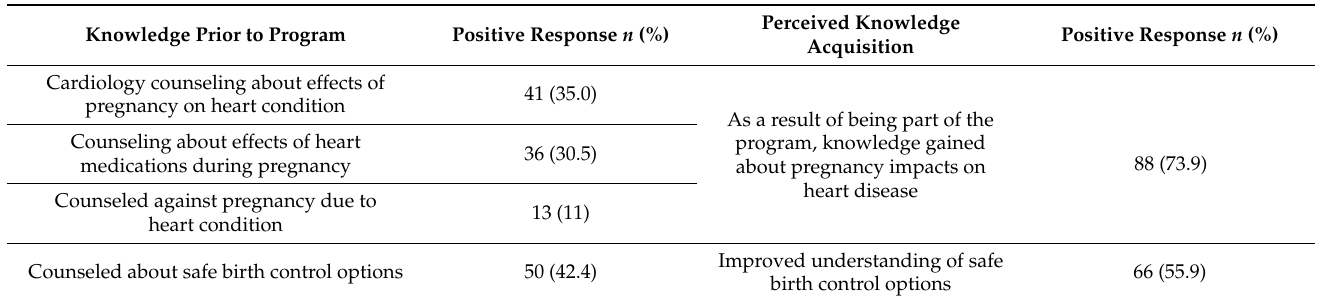
Table 5. Perceived knowledge gained as a result of participating in the combined Cardio-Obstetrics clinic of Saint Luke’s Hospital of Kansas